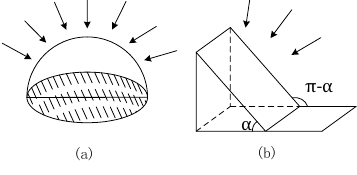
Figure 3 (a) SVF=1, (b) SVF<1.(Li,